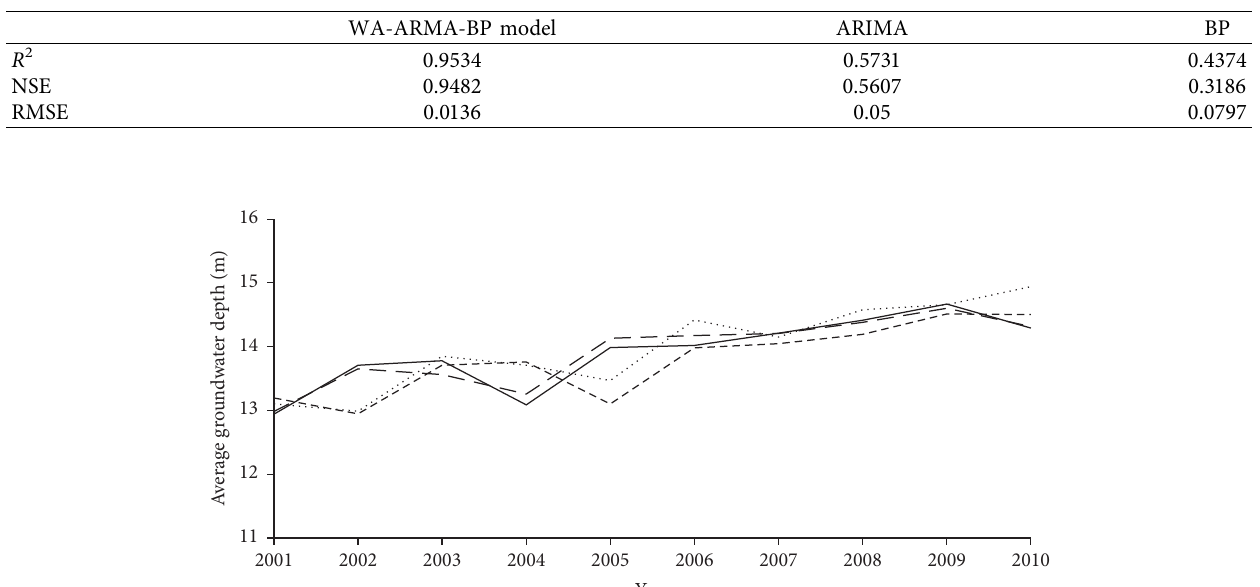
Table 4: Comparison of the best WA-ARMA-BP model with the best ARIMA model and BP neural network model for average groundwater depth forecasting during the testing period.